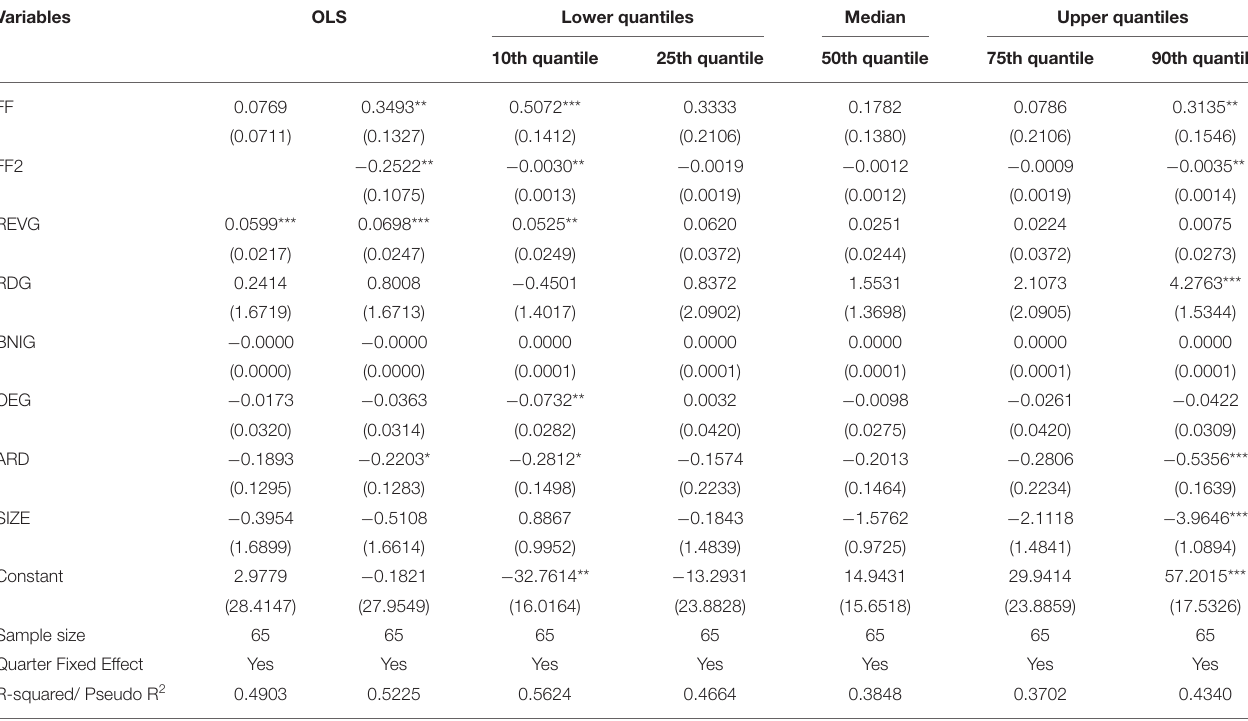
TABLE 6 | Quantile regression results of the AHBM hotel